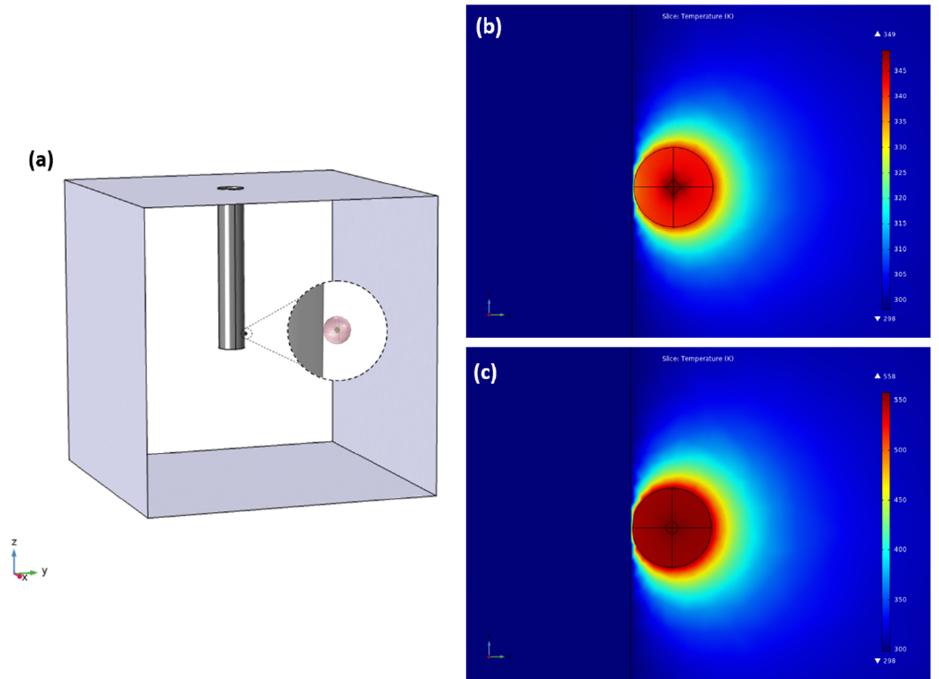
Figure 6. ( a ) Geometry of the laser heating simulation. Temperature map in (K) within and around the microsphere heated with 112 mW of pump power at ( b ) atmospheric pressure and ( c ) 20 Pa vacuum.